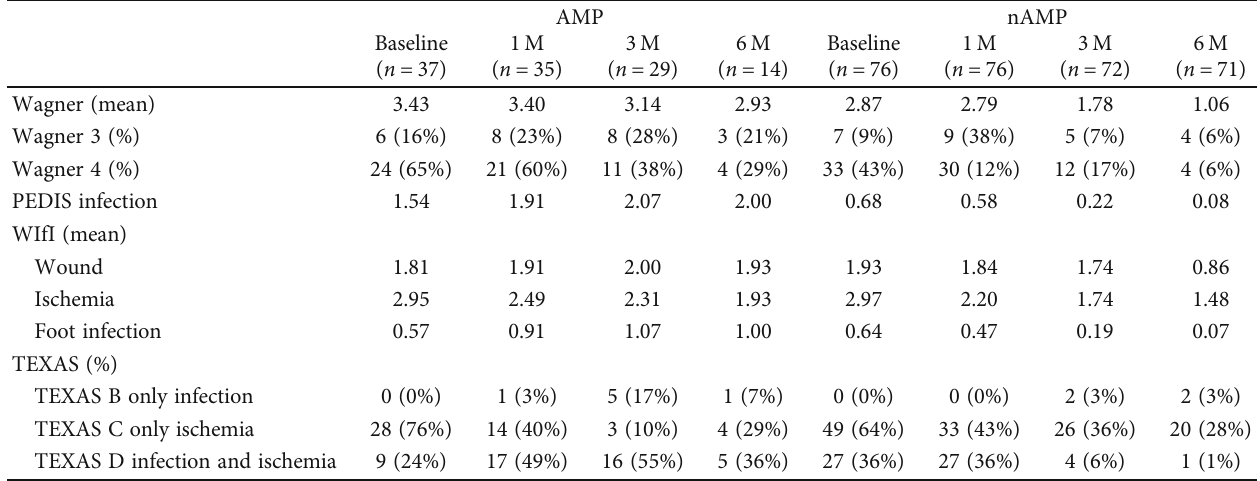
Table 2: Classi fi cation systems of DFU at baseline and at all follow-up